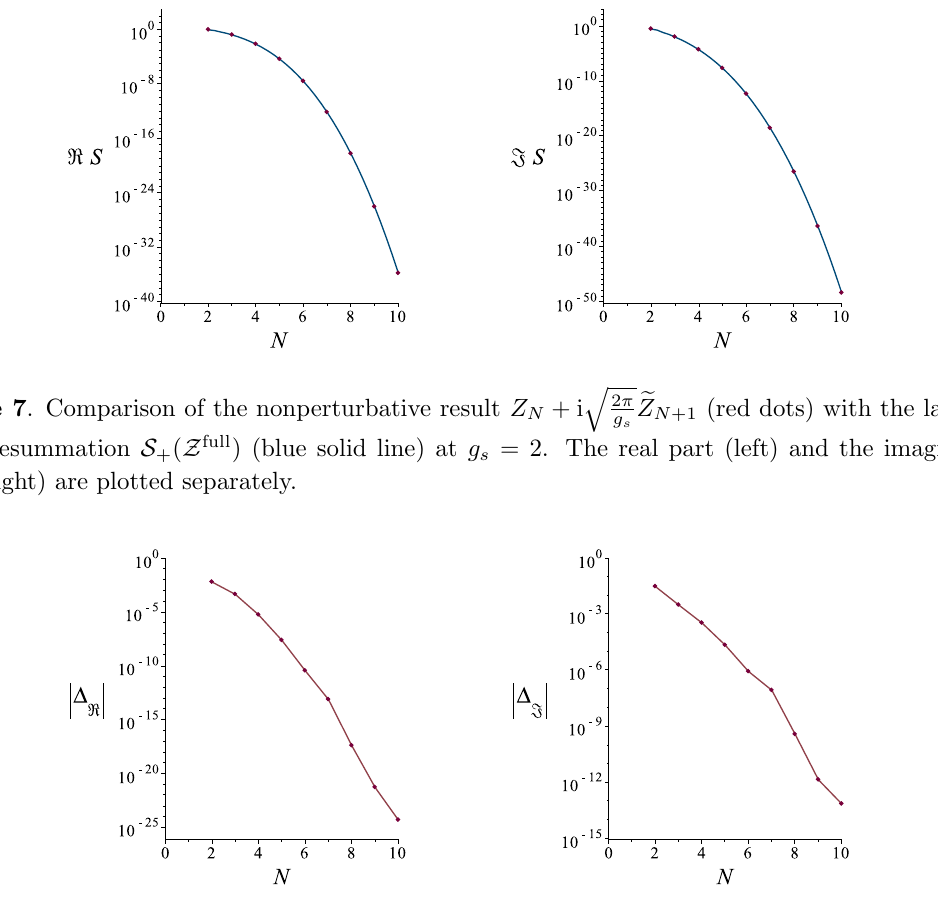
Figure 8 . Relative deviations of the lateral Borel resummation S + ( Z full ) from the nonperturbative q 2 (cid:25) result Z N + i e Z N +1 at g s = 2. The real part (left) and the imaginary part (right) are plotted g s separately.